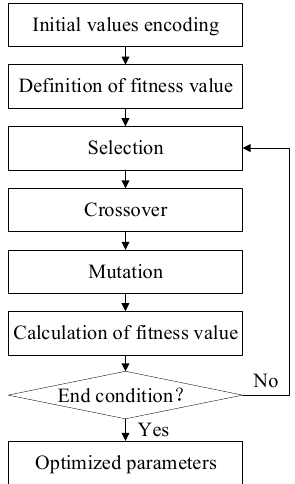
Figure 5. Flowchart of the genetic algorithm.